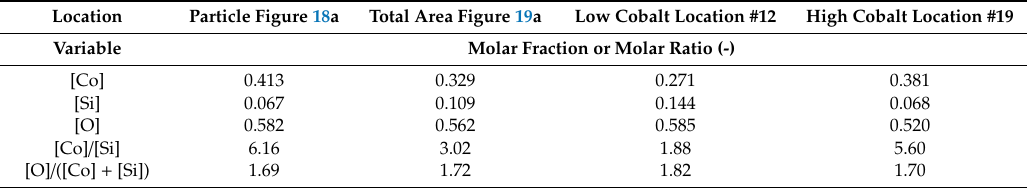
Table 8. Summary of the data from Figures 18 and 19 illustrating the heterogeneity in Co / Si = 1 catalyst as evaluated from Figures 18 and 19. Spot analysis location in Figure 19b are #12 and #19. Location Particle Figure 18a Total Area Figure 19a Low Cobalt Location #12 High Cobalt Location #19 Variable Molar Fraction or Molar Ratio (-) [Co] 0.413 0.329